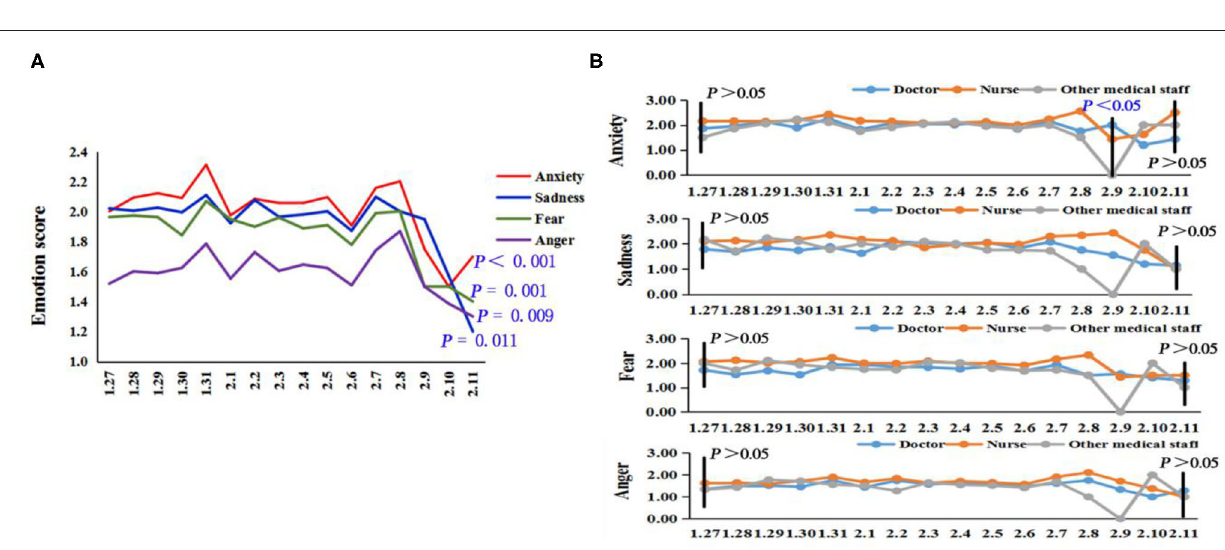
Interaction Pathway Between Negative Emotions and Their Influential Factors To further explore the interaction between negative emotions